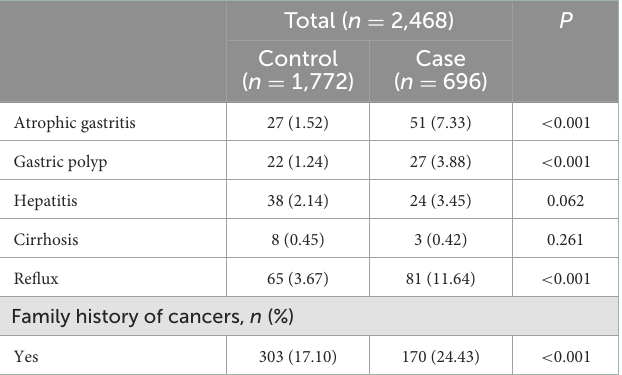
TABLE 1 Characteristics of the